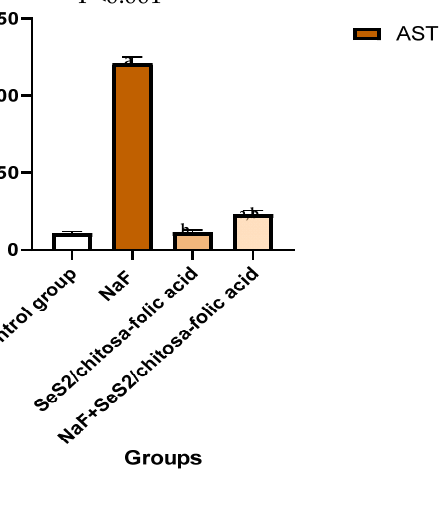
Figure 8. Photomicrographs of H&E-stained sections in the liver of the ( A ) control group showing normal hepatic cells and ( B ) sodium fluoride (NaF)-treated male rats showing a photomicrograph of the cross section of the experimental rat liver after administration of toxic substances showing severe toxicity in the form of hypertrophy of hepatocytes with the appearance of binucleated